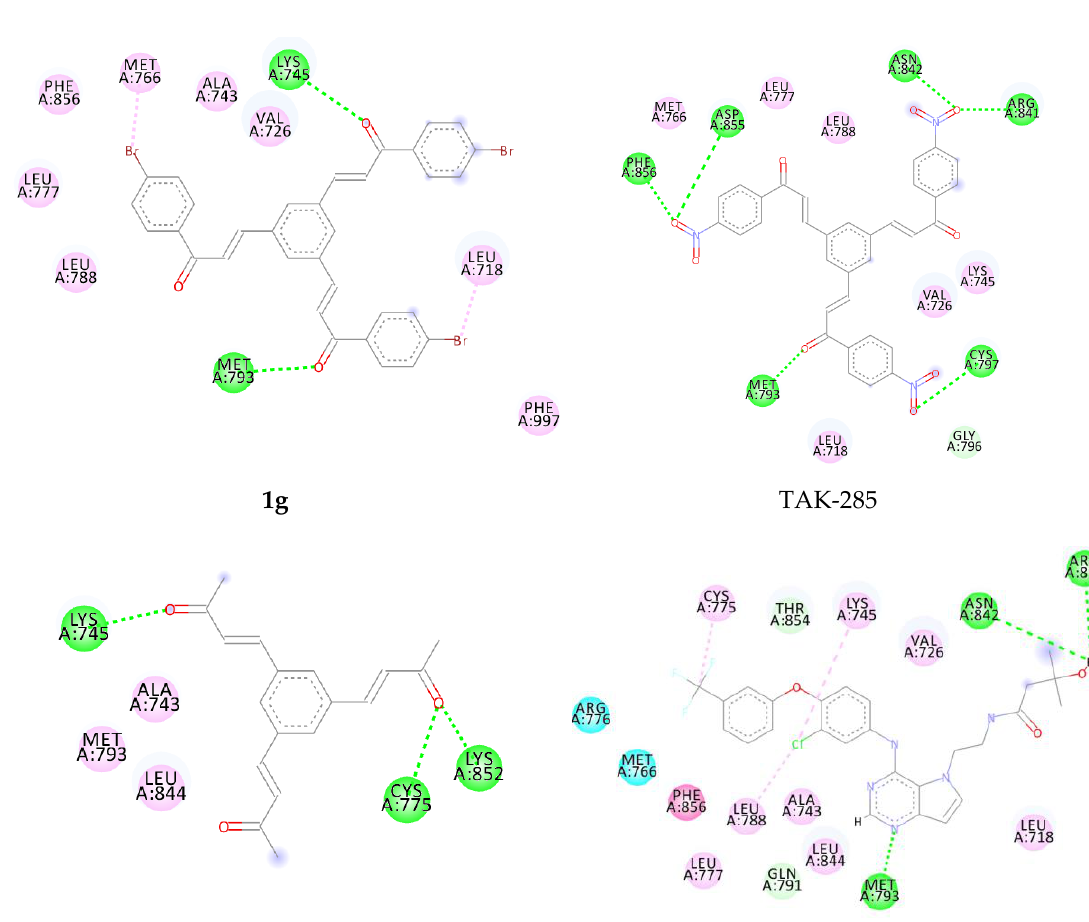
Figure 2 . 2D intermolecular interactions between docked compounds (1a – 1g and TAK-285) and 3POZ protein. Green and Pink colored amino acids represent their contribution in hydrogen bond and hydrophobic interactions, respectively.